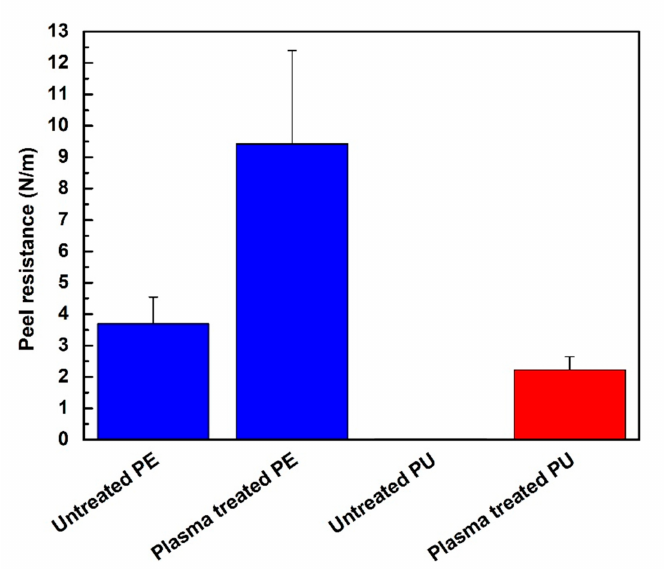
Figure 5. Peel resistance for PDMS/PA electrospun fiber mats of PE and